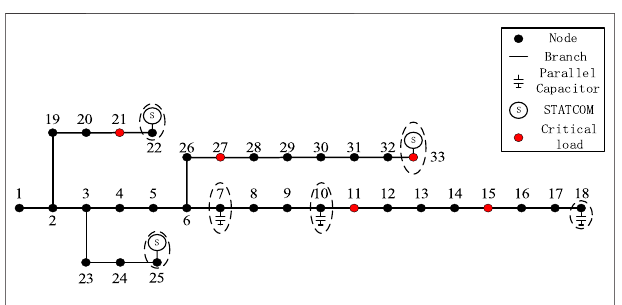
FIGURE 9 | IEEE 33-bus distributed network